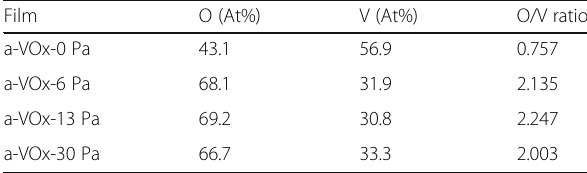
Table 1 Elemental composition of a-VOx